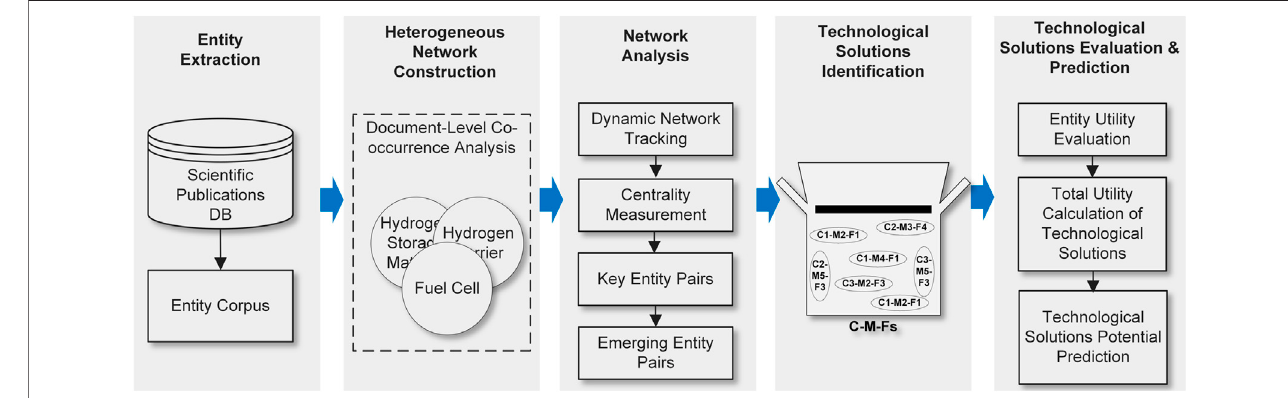
FIGURE 1 | The analysis framework of our proposed methodology.